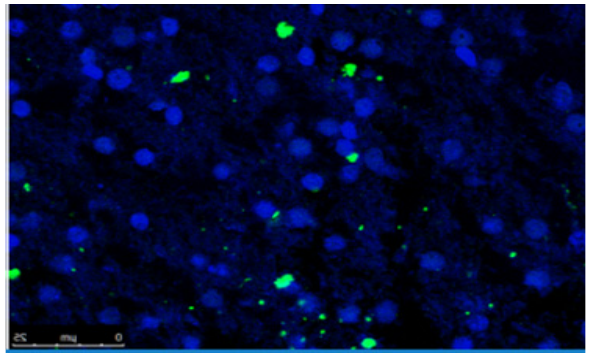
Figure 1. Brainstem section. In situ detection of Listeria monocytogenes antigen (green color) and cellular nuclei (blue color), scale bar: 25 µm.